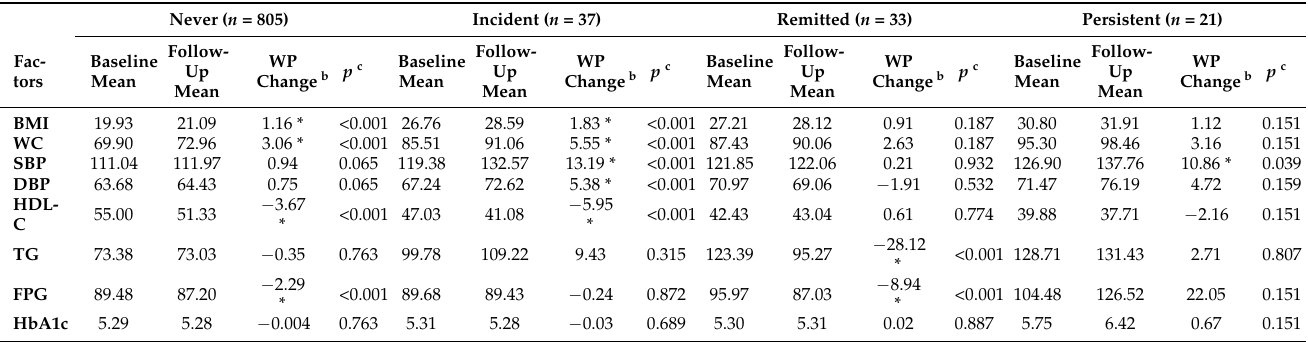
Table 4. Distributions and changes of cardiometabolic risk factors between baseline and follow-up for never, incident, remitted, and persistent metabolic syndrome a in adolescents.